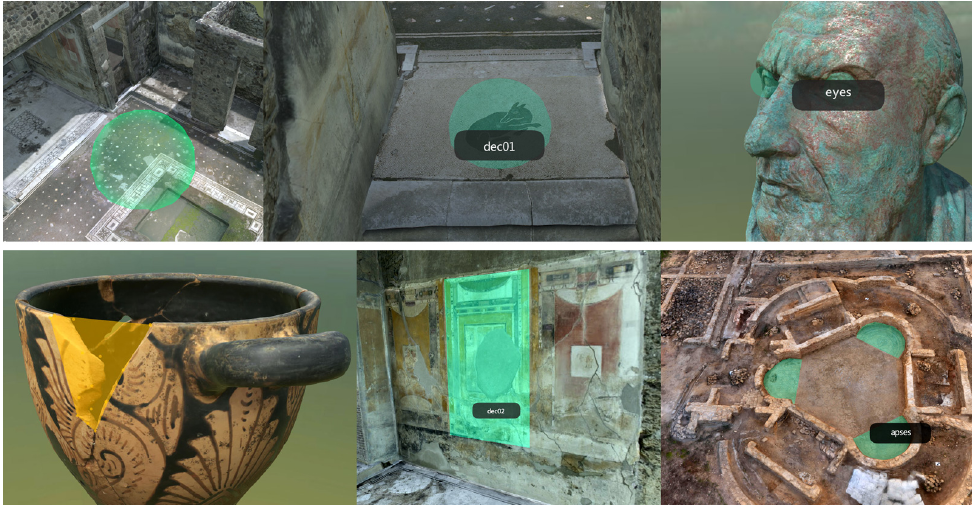
Figure 11. Top row : basic (spherical) annotations interactively added using current 3D selector location and radius, with multiple shapes under the same semantic node ID (e.g., “eyes”, top right). Bottom row : free-form semantic annotations interactively created at runtime using multiple surface points at different scales.